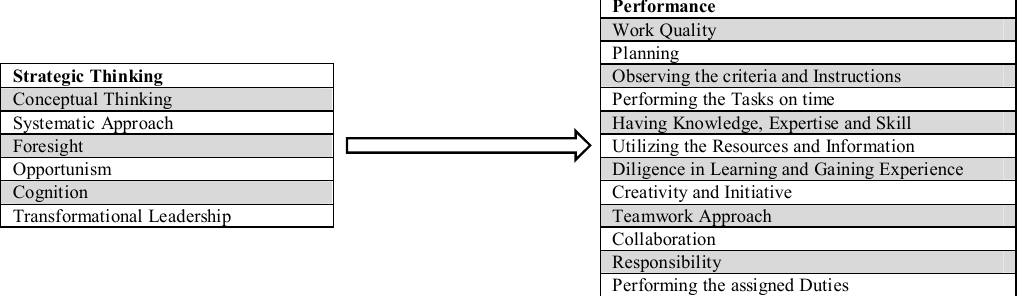
Fig.1. Dimensions of Strategic Thinking (Goldman, 2005; Ja’faryani, 2011; Rezvanpour,